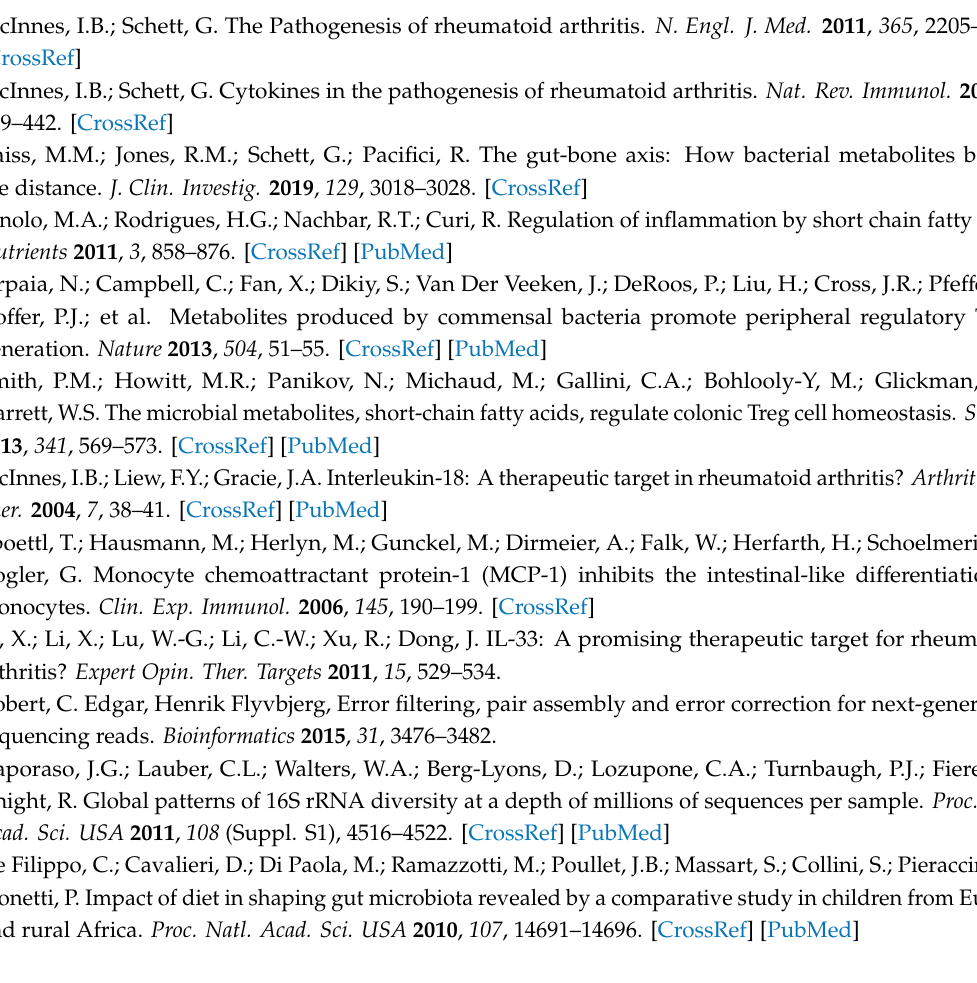
Figure S1: 16S rRNA sequencing results from healthy controls, Figure S2: 16S rRNA sequencing results from RA